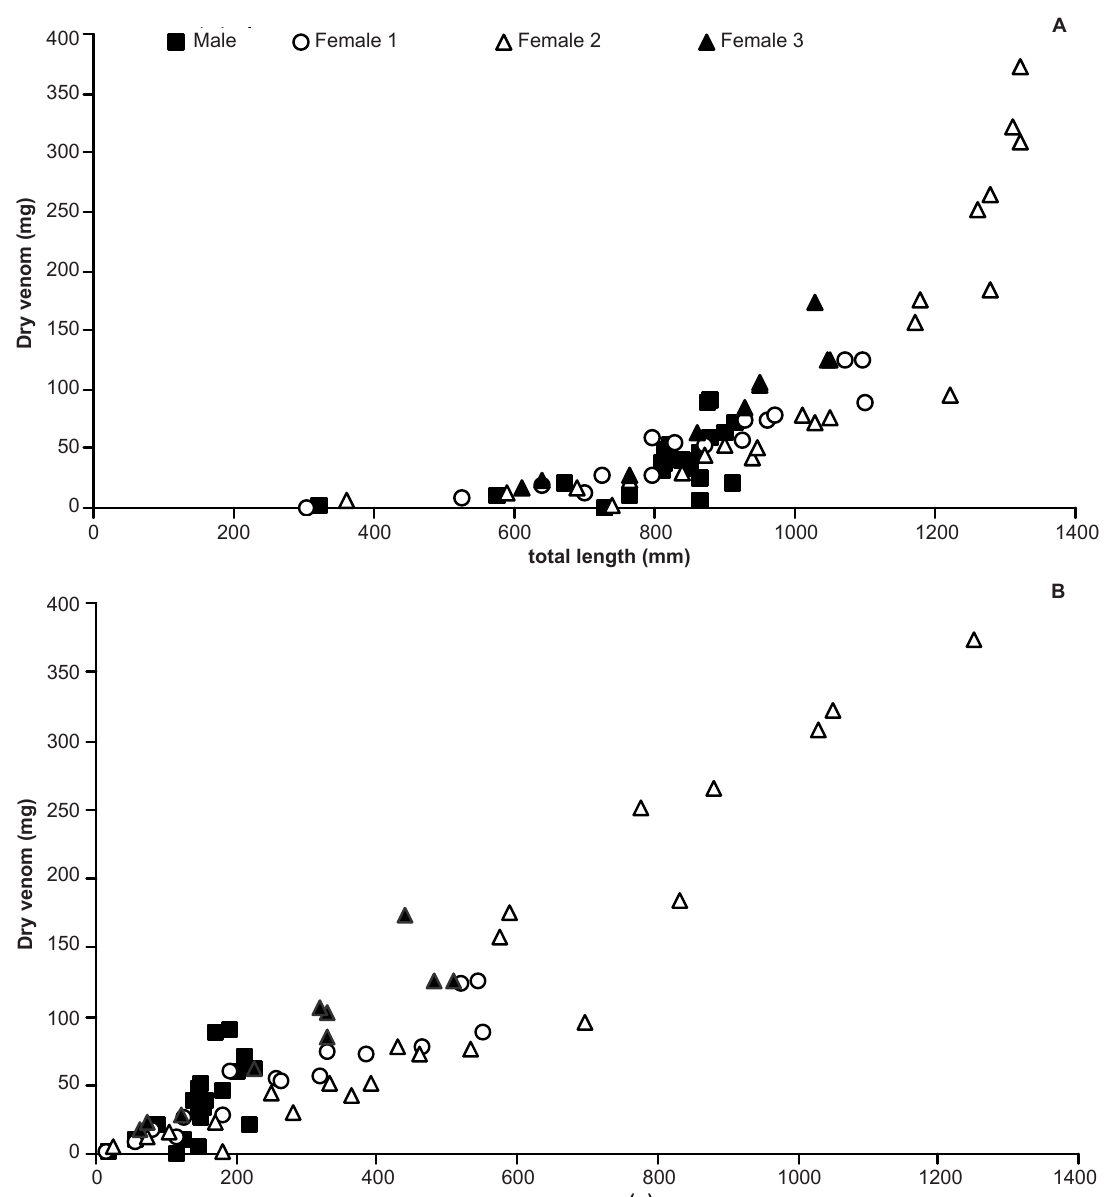
Figure 4. yields of venom produced (mg) x total length (mm) (A); and venom produced (mg) x mass (g) (B) of Bothrops